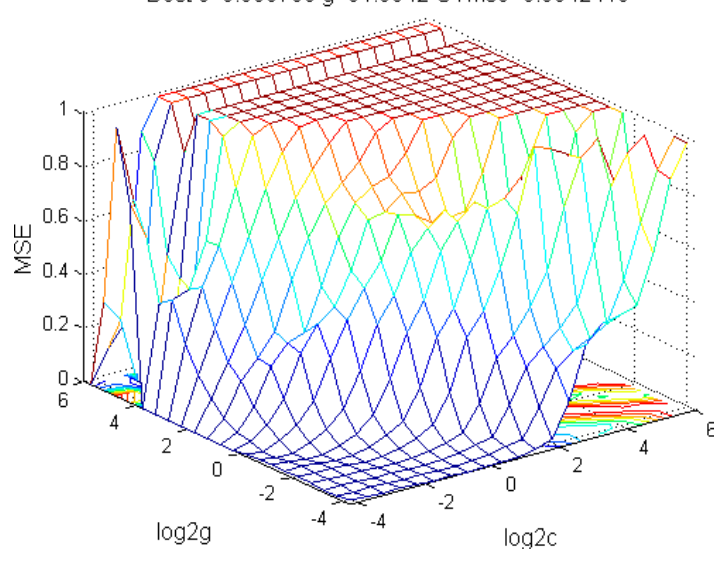
Figure 6. Parameter optimization of C and g .